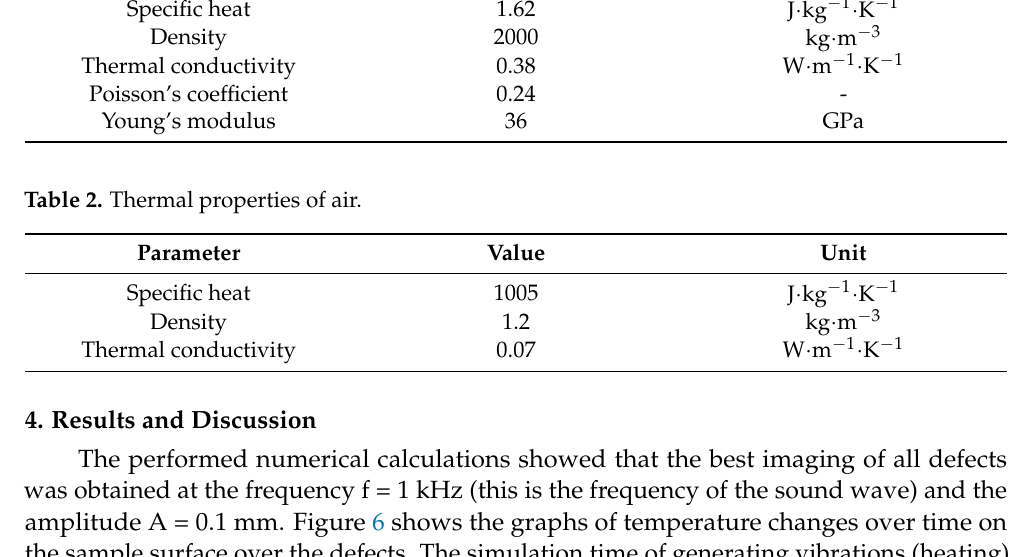
Table 1. Thermal and strength properties of the composite [26].